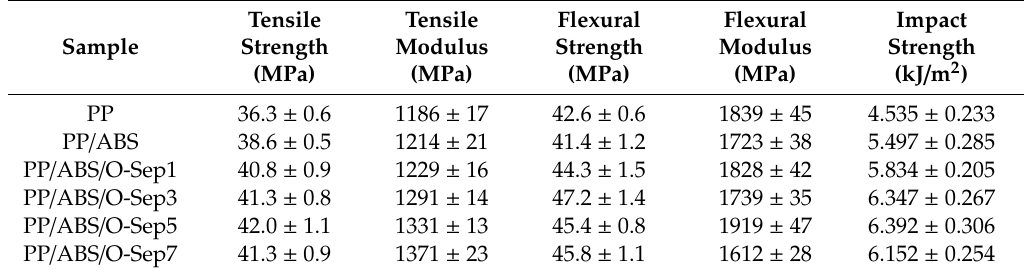
Figure 2. SEM images of cryofractured surfaces of PP and PP / ABS / O-Sep nanocomposites: ( a ) PP, ( b ) PP / ABS, ( c ) PP / ABS / O-Sep1, ( d ) PP / ABS / O-Sep3, ( e ) PP / ABS / O-Sep5, and ( f ) PP / ABS / O-Sep7. Table 2. Mechanical properties of PP and PP / ABS / O-Sep